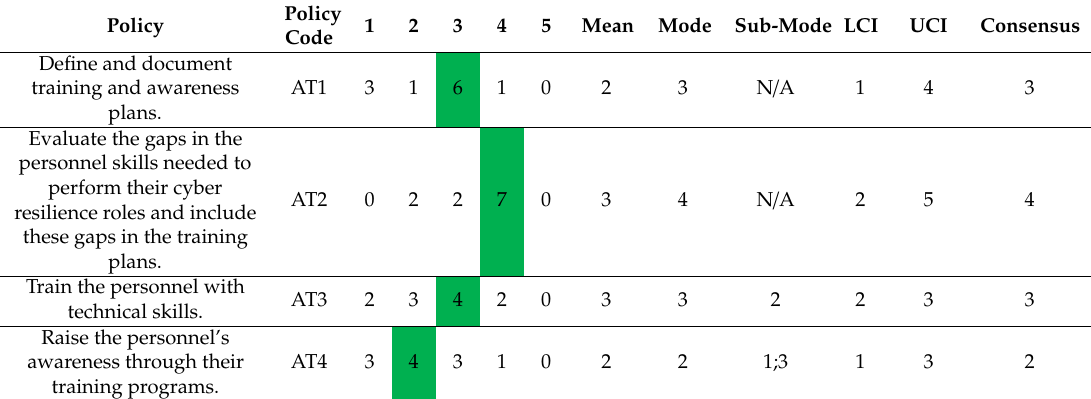
Table 17. Awareness and training policies’ starting maturity.